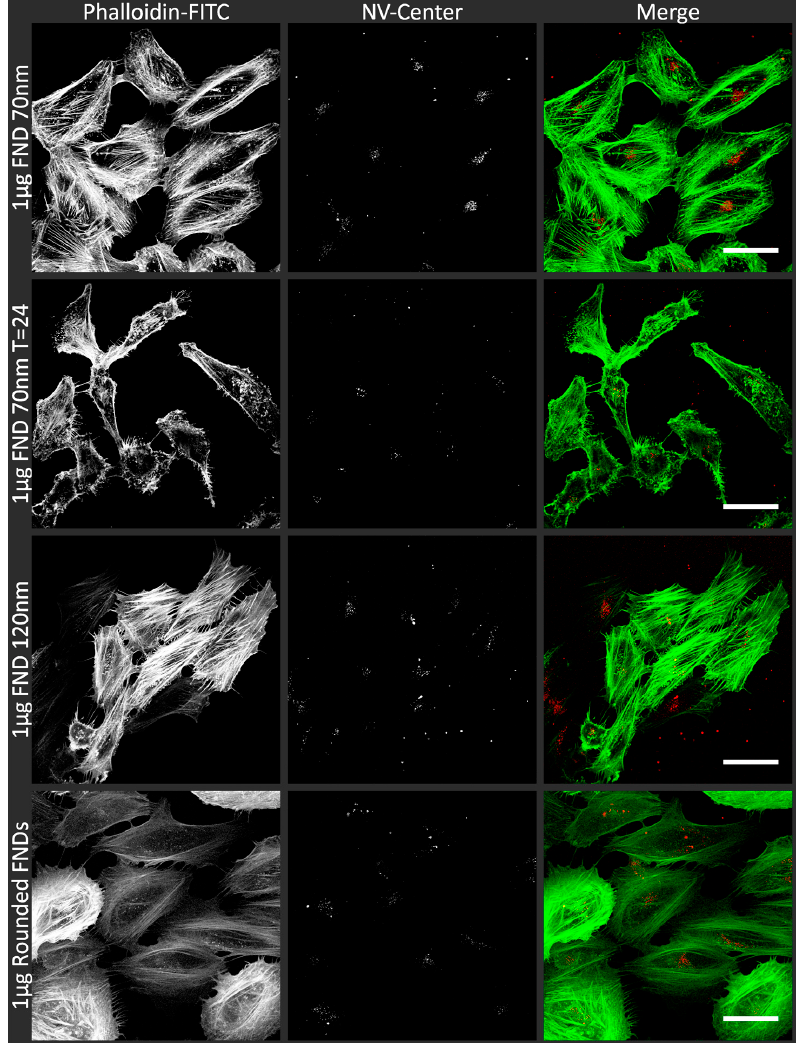
Figure 1. Confocal images of HeLa cells incubated with FNDs. To visualize internalized nanodiamond particles (in red), HeLa cells were fixed with 3.7% PFA and subsequently stained with Phalloidin-FITC and imaged using a LSM780 microscope. Phalloidin-FITC stains the actin cytoskeleton of the cells (in green). For visualization purposes, both signals are shown in white and merged. As examples, cellular uptake of the standard situation (1 µg FND 70 ), the uptake after 24 h, cells with 120 nm FNDs (1 µg FND 120 ) and cells with rounded FNDs are shown. The morphological differences between the cells in the images are a natural variation. As each cluster grows out of one mother cell, they resemble the closest sister cells but not by definition the cells of other clusters. The images were recorded in z-stacks and a focal plane was chosen to display here, approximately 2 µm above the cover glass, as these show the largest volume of the cells. The scale bars in these single optical section images represent 50 µ